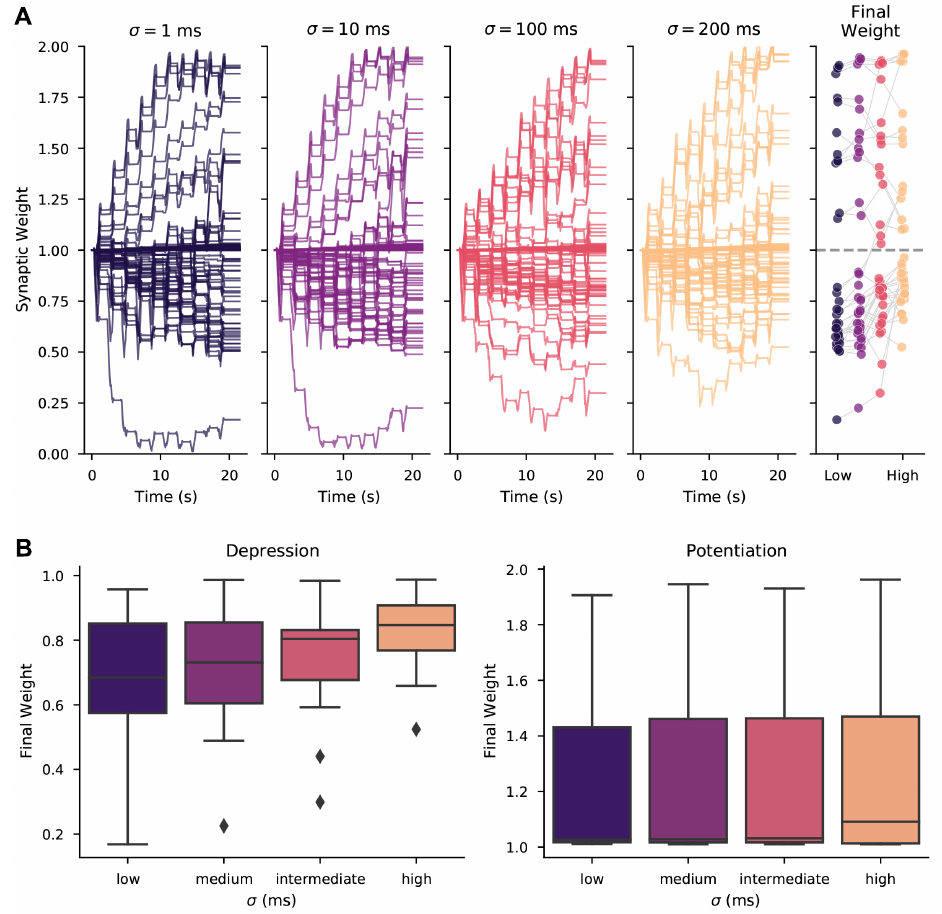
Figure 4. Synaptic plasticity is robust to trial-to-trial variability. ( A ) The weight of every synapse over a full 10-trial experiment is shown for different trial-to-trial variability conditions, with the σ value corresponding to the standard deviation of random jitter of spike times. (Right) Ending weight of each synapse is shown for each variability condition (synapses with near zero weight change excluded for visualization). ( B ) Distribution of final weights grouped by potentiation and depression shows that variability reduces synaptic depression magnitudes, but has little effect on the distribution of potentiation magnitudes. Correlation of ending synaptic weight versus variability was significant for depressing synapses (R = 0.306, p = 0.0006, N = 121 events), but not for potentiating synapses (R = 0.054, p = 0.510, N = 148